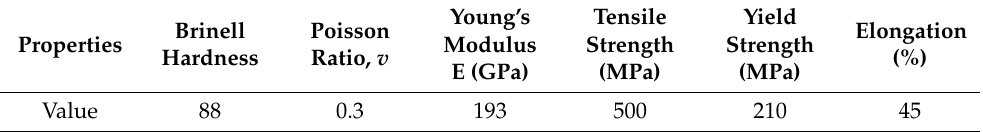
Table 3. Mechanical properties of AISI 304